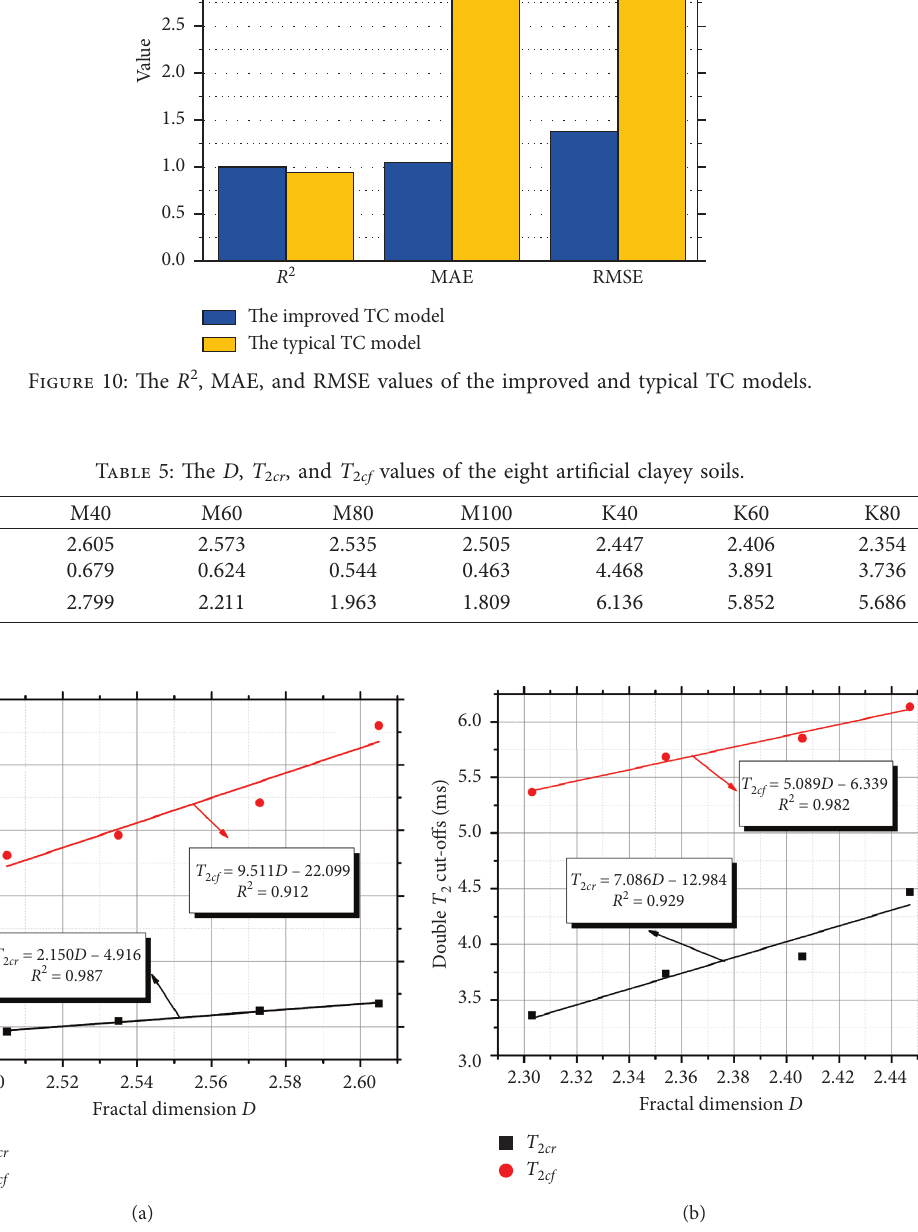
Figure 11: The relationships between the double T 2 cut-offs and fractal dimensions: (a) M-group and (b)